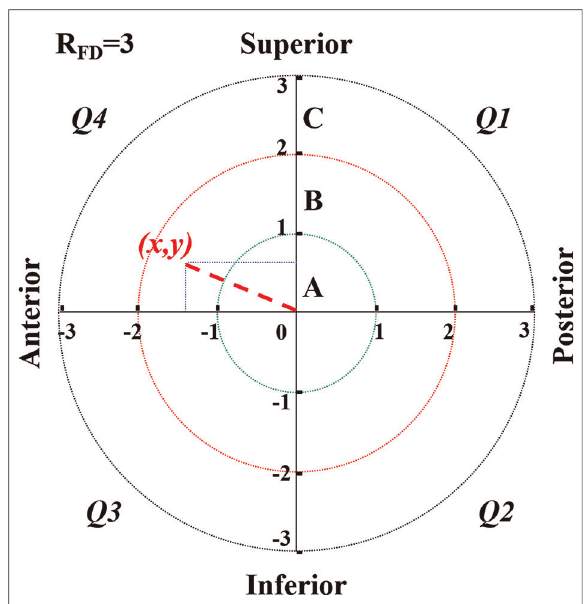
FIGURE 2 ED zone analysis system is just like the coordinate graph (an x – y plot). In this system, no matter how big the radius of the femoral head ( R FD ) was, we standardized the R FD as “ 3 ” ( R FD = “ 3, ” without any unit) for a good match with the Cleveland zone system and easy calculation. We de fi ned the femoral head into three zones named Zone A (remote zone), B (subcenter zone), and C (center zone) in turns by three concentric circles (circle A, B, and C) with the radius of 3/3, 2/3, and 1/3 times of R FD , respectively ( R A , R B, and R C was “ 3, ” “ 2, ” and “ 1, ” accordingly). The femoral head was divided into four quadrants (Q1, 2, 3, and 4). ED of the tip point ( x, y ) is the distance from the circle center to the point of ( x,y ). ED, eccentric